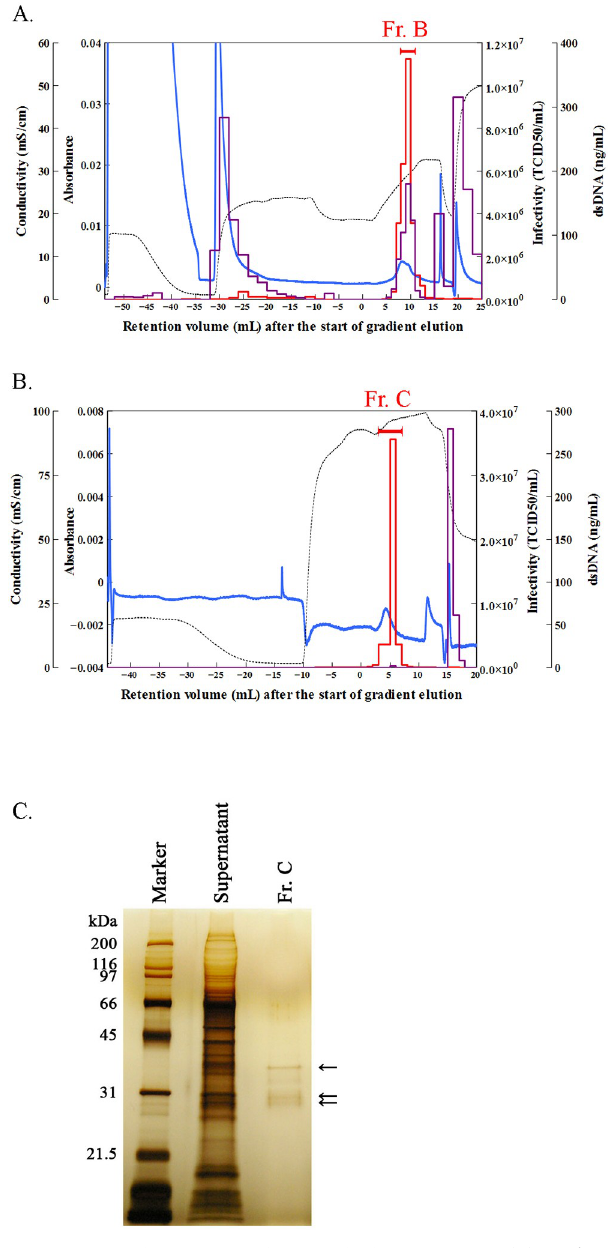
Fig 4. Sequential two-step purification of Sabin type 2 virus. (A) Purification of Sabin type 2 virus by pH gradient elution on a ceramic fluoroapatite (CFAp) column (Step 1). Column, CFAp; sample (volume), cell culture supernatant containing Sabin type 2 virus (10 mL); wash, 10 mM sodium phosphate buffer (NaPB) (pH 6.4, 9 mL) and 300 mM NaPB (pH 6.4, 20 mL); equilibration, 15 mL of 300 mM NaPB (pH 5); elution, linear gradient from pH 5 to pH 8.2 at 300 mM NaPB for 10 mL; wash after separation, 300 mM NaPB (pH 8.2, 5 mL) and 600 mM NaPB (pH 8.2, 10 mL). Lines are the same as in Fig 2. Fr. B was pooled and further purified in Step 2. (B) Removal of double-stranded DNA (dsDNA) from the Fr. B fraction by NaPB elution with 1 M NaCl on a ceramic hydroxyapatite (CHAp) column (Step 2). Column, CHAp; sample (volume), Fr. B obtained in (A) diluted 6.7-fold with 0.9% NaCl (17 mL); buffer, pH 7.2; column wash, 10 mM NaPB (13 mL); equilibration, 10 mM NaPB (14 mL) with 1 M NaCl; elution, linear gradient from 10 mM to 187 mM NaPB with 1 M NaCl for 10 mL; wash, 600 mM NaPB (10 mL). Fr. C was pooled for further evaluation. (C) Sodium dodecyl sulfate–polyacrylamide gel electrophoresis (SDS–PAGE) analysis of the pooled fraction obtained through the two-step purification process. The pooled Fr. C fraction obtained in (B) and the cell culture supernatant were concentrated 100- and 10-fold, respectively, by ultrafiltration using a molecular weight cutoff of 10,000. The sizes are given in kDa on the left. Arrows indicate the major proteins in Fr. C. TCID 50 , median tissue culture infectious dose.